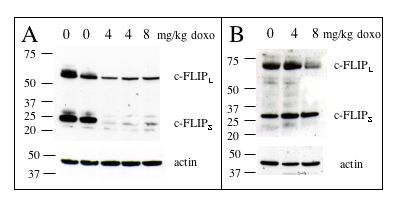
Effect of doxorubicin on c-FLIP in vivo Mice bearing PC3 xenografts were untreated or treated with 4 mg/kg or 8 mg/kg doxorubicin (i.p.). After 24 hours, protein was isolated from xenografts (A) or mouse heart (B) and probed for c-FLIP expression by western blotting. Actin was included as a loading control.